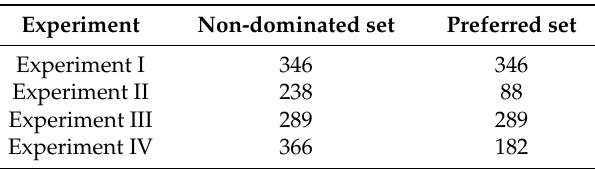
Table 9. Size of non-dominated and preferred